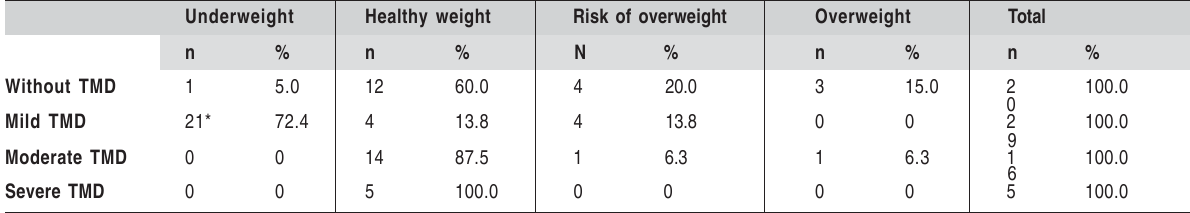
Table 3. Distribution of individuals according to the severity of TMD and BMI per percentile